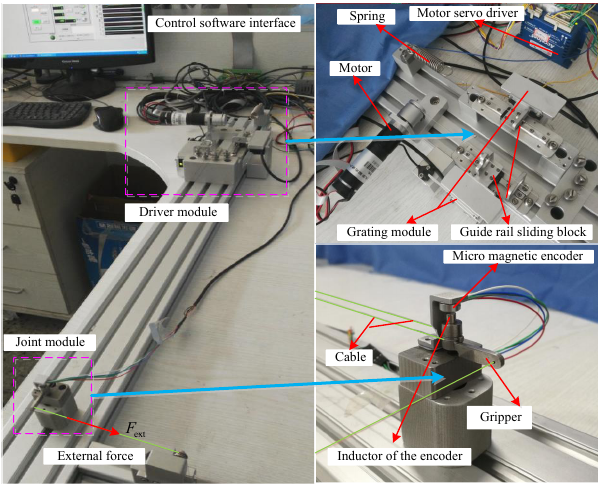
Figure 7. Experimental design of the single joint prototype